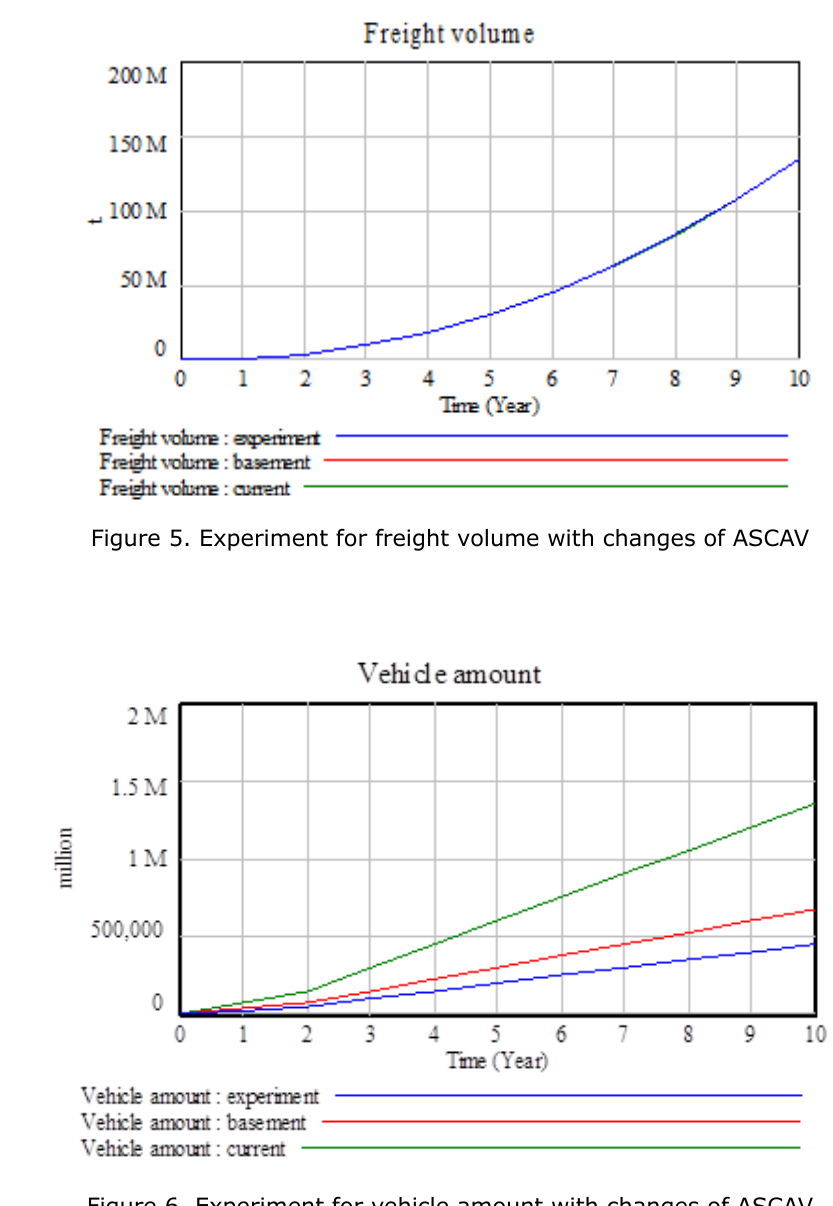
Figure 6. Experiment for vehicle amount with changes of